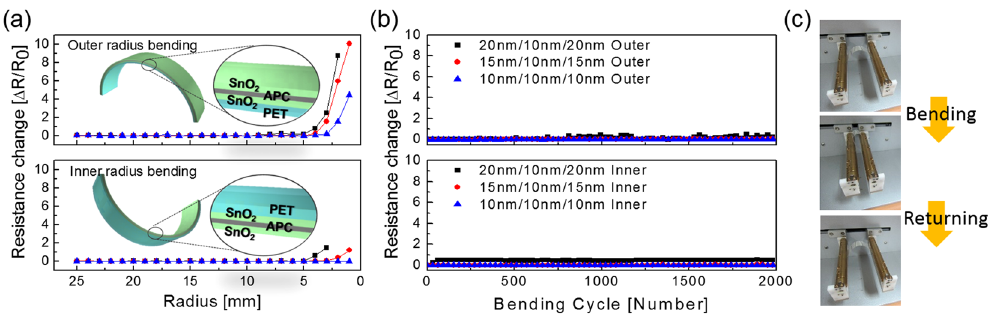
Figure 9. ( a ) Inner and outer bending and ( b ) dynamic fatigue tests of the thermally evaporated SnO 2 /APC/ SnO 2 multilayer film as a function of the top and bottom SnO 2 layer thickness. ( c ) Pictures show the bending steps during the dynamic fatigue